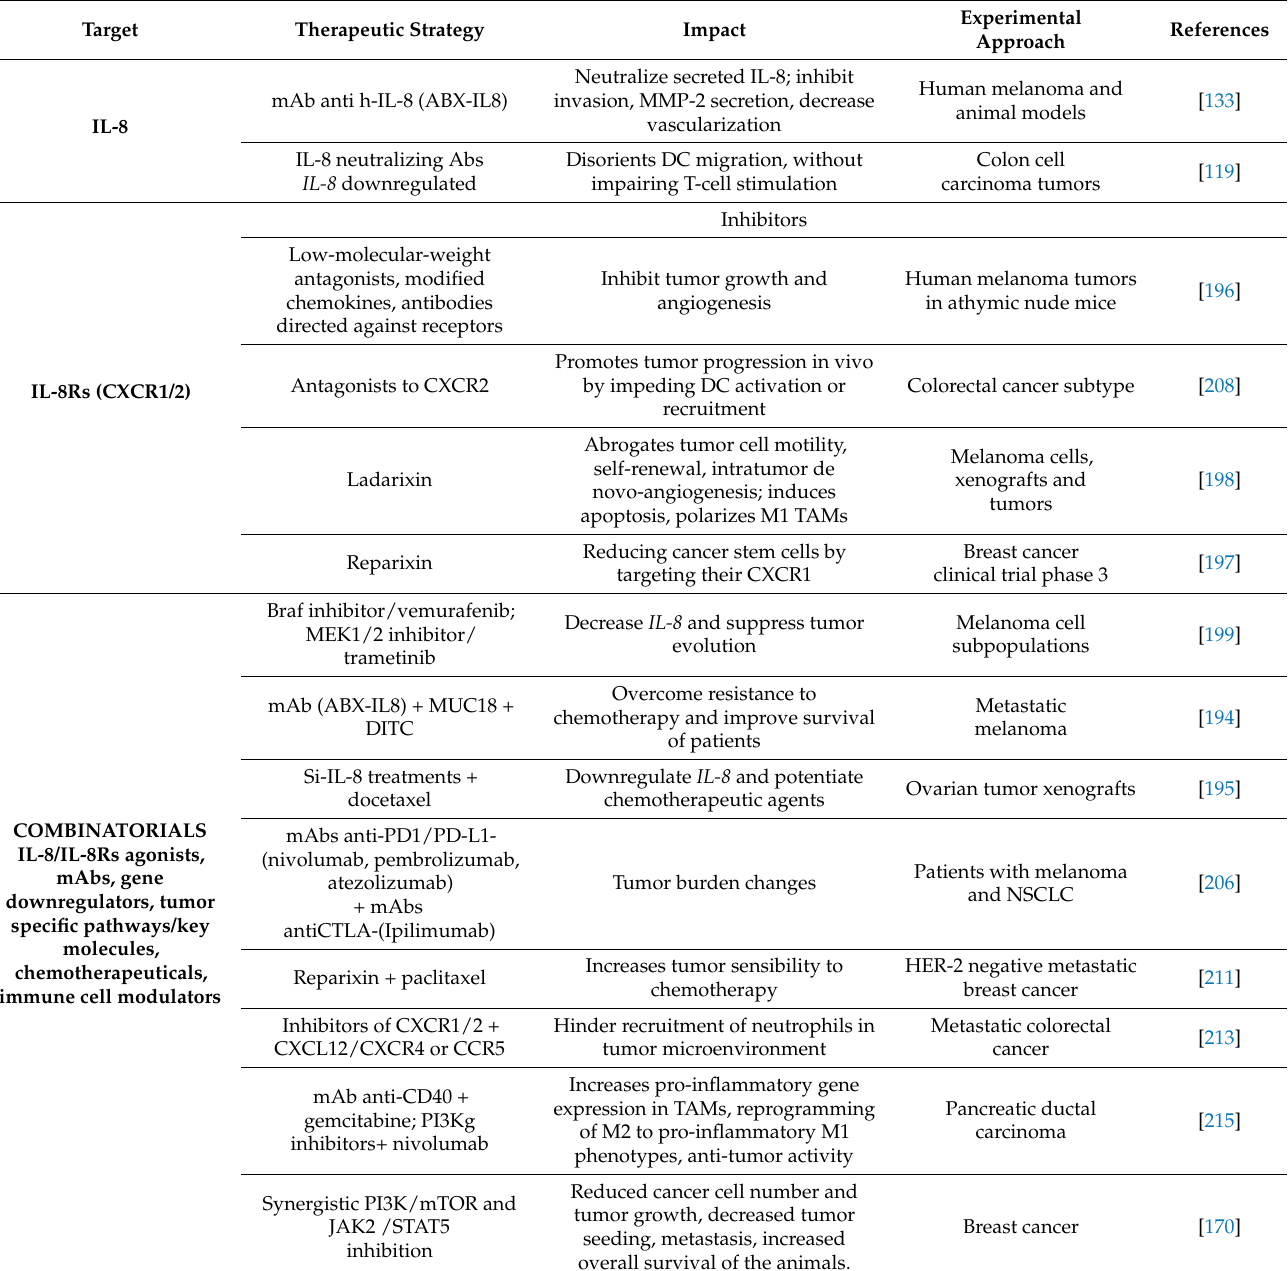
Table 2. Strategies of targeting IL-8/IL-8Rs in therapies of CM and other